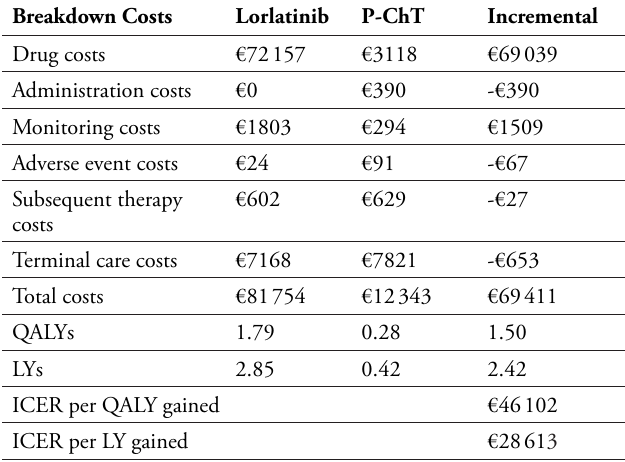
Table 3. Cost-effectiveness Results